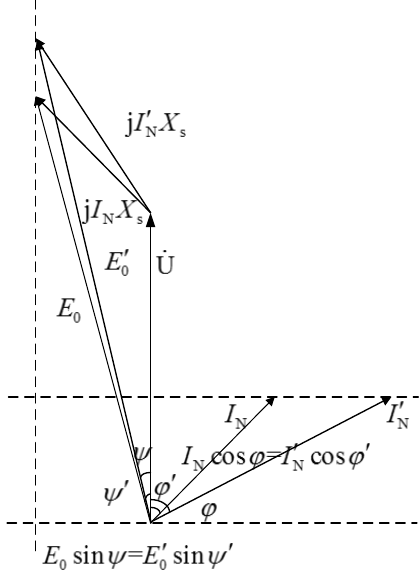
Figure 18. Synchronous generator grid-connected operation vector diagram.